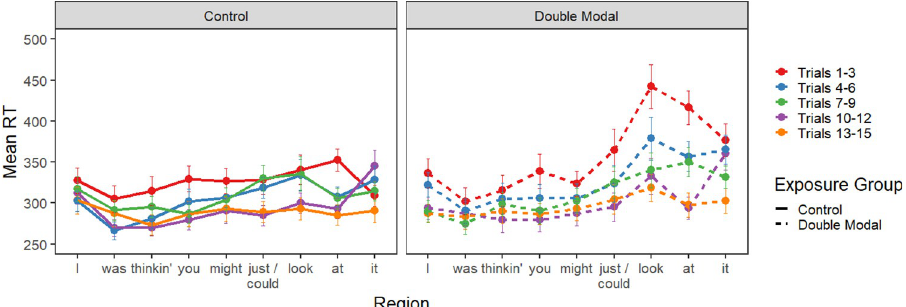
Fig 8. Experiment 4 exposure block. Mean reading times for critical sentence regions by trial number grouped in bins of 3 trials. Data from the control group are plotted on the left, while that from the double modal exposure group are plotted on the right.